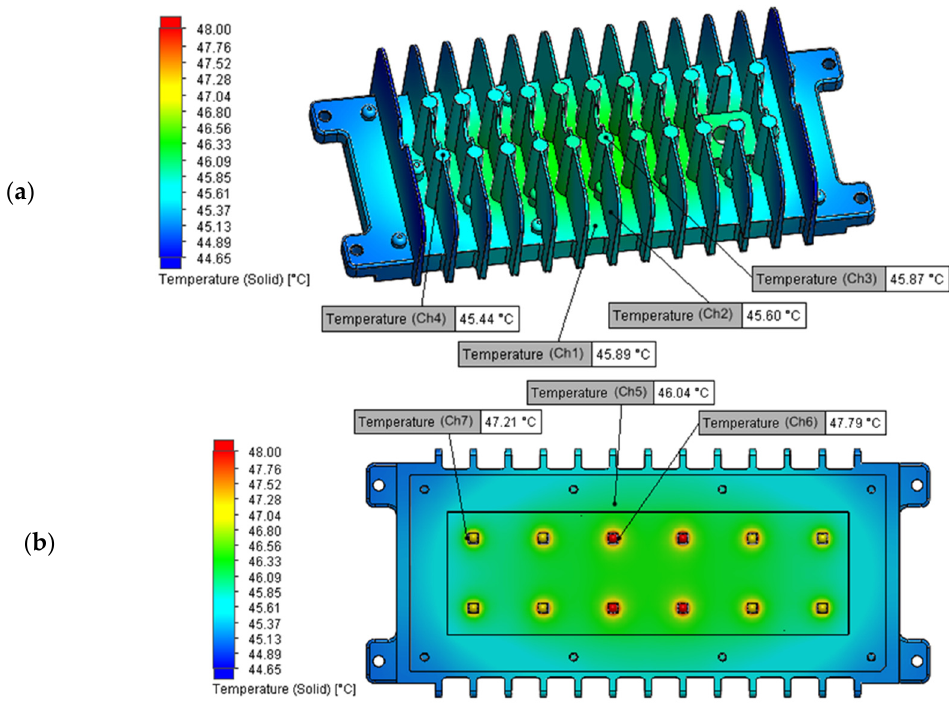
Figure 9. Temperature distribution of the LED panel for I F = 700 mA, with characteristic measuring points: ( a ) top view of the LED panel, ( b ) bottom view of the LED panel.